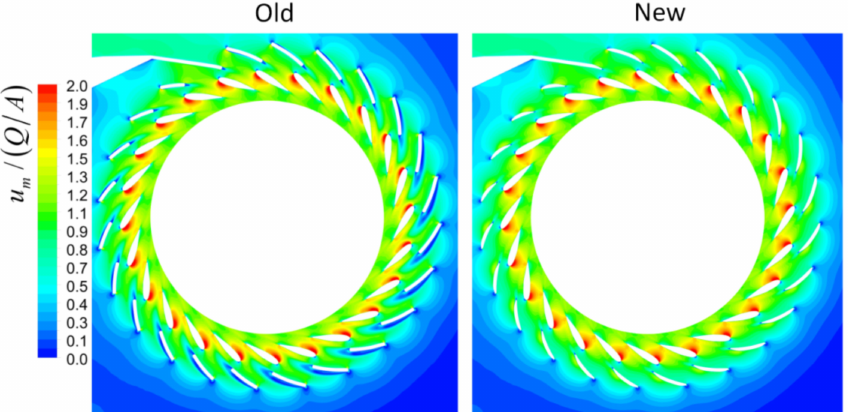
Figure 12. Flow velocity at the tandem cascade horizontal plane in case 1 hydraulic turbine functions of the inlet area of the spiral case and the turbine discharge.